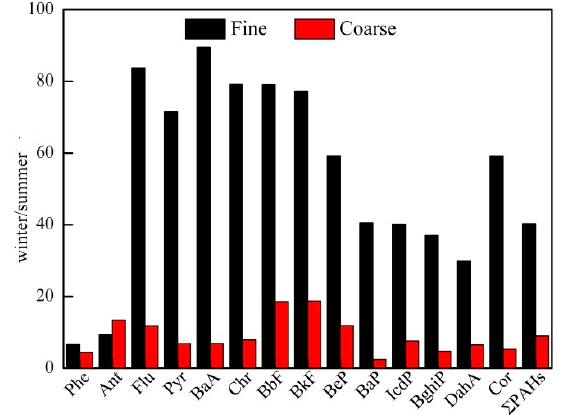
Figure 3. Winter to summer ratios of atmospheric PAHs for fine and coarse particles. The w/s was calculated by the concentration of PAHs in winter divided by concentration of PAHs in summer.